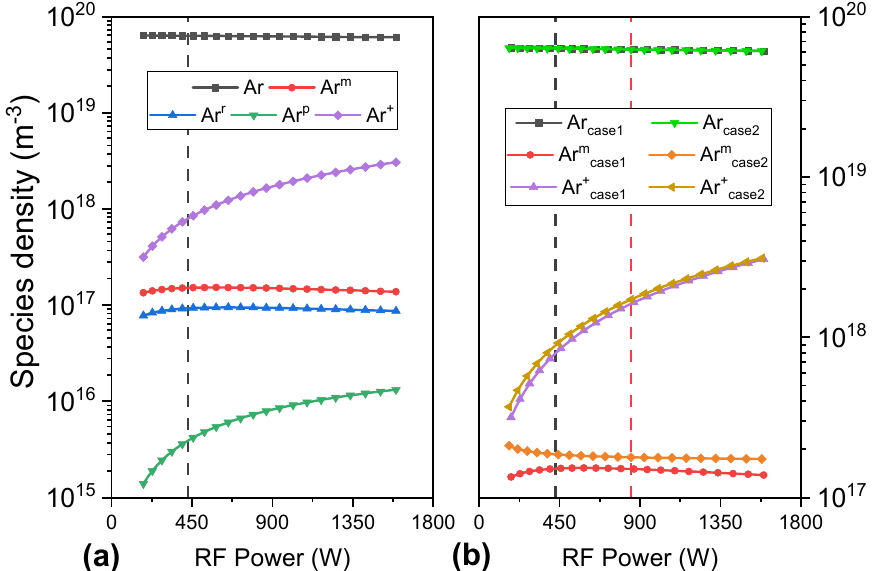
Figure 2. Current density through the grids for the two reaction set configurations as a function of RF power. The dashed lines indicate the Child–Langmuir limit for the respective inlet currents, and at a pressure of 2 mTorr.